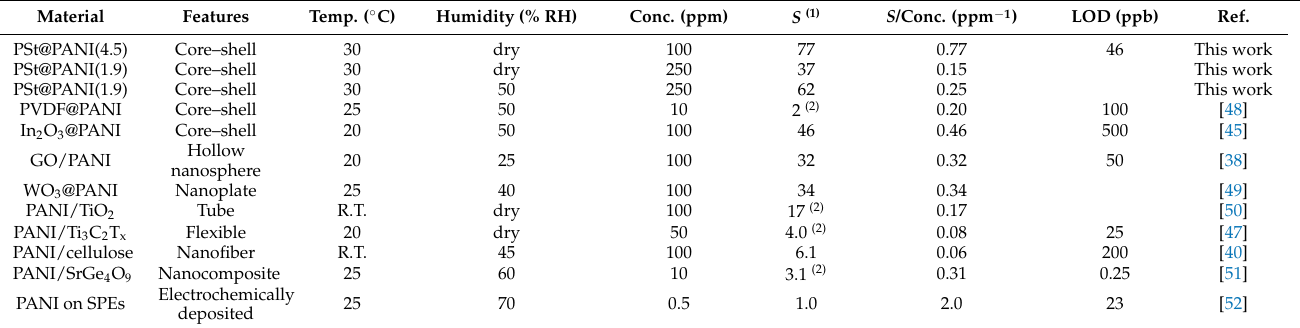
Table 2. Comparison of PANI-based NH 3 gas sensing performances of the present sensor with other previously reported